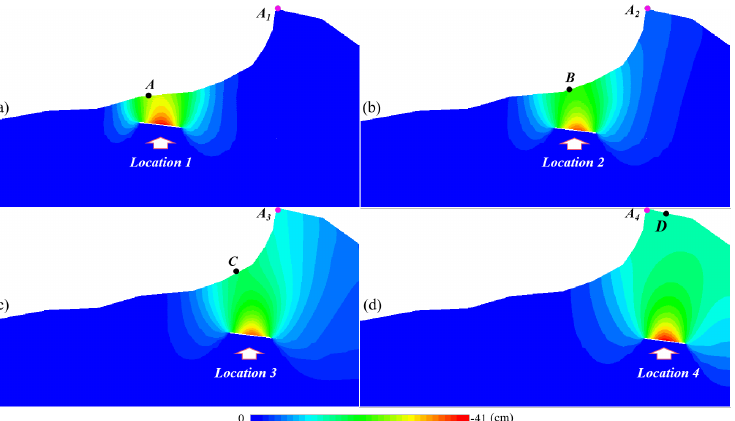
Figure 9. The influence of mining at different locations on the mountain: ( a ) simulation results of mining far away from the top of the mountain; ( b ) simulation results of mining at the foot of the mountain; ( c ) simulation results of mining under mountainside; ( d ) simulation results of mining under the top of the